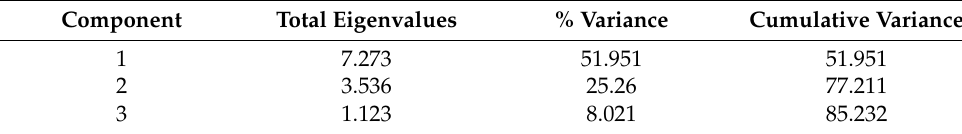
Table 5. Top three principal components analysis eigenvalues and variance.